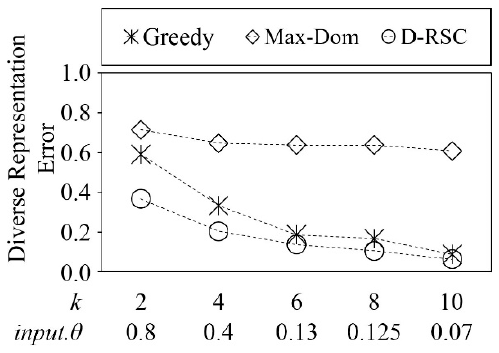
Figure 12. Comparison of diverse representation error on Anisotropic dataset.